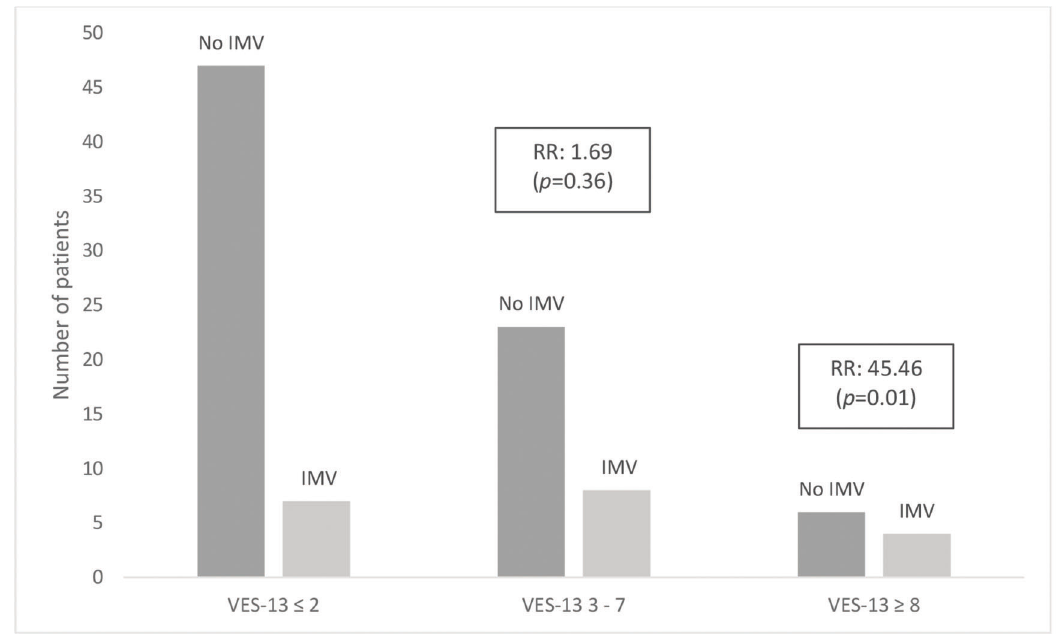
Figure 2 - Association between VES-13 and invasive mechanical ventilation. IMV = invasive mechanical ventilation, VES-13 = Vulnerable Elders Survey, RR = Relative